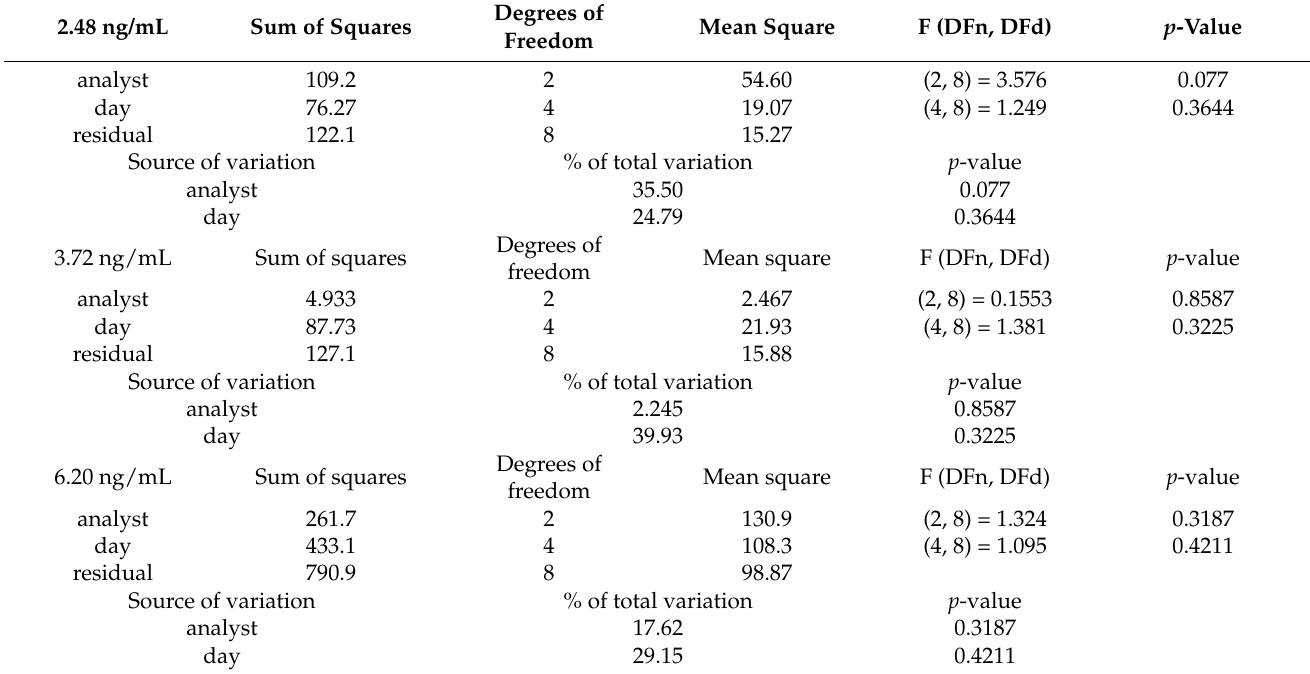
Table 2. Two-way ANOVA results.